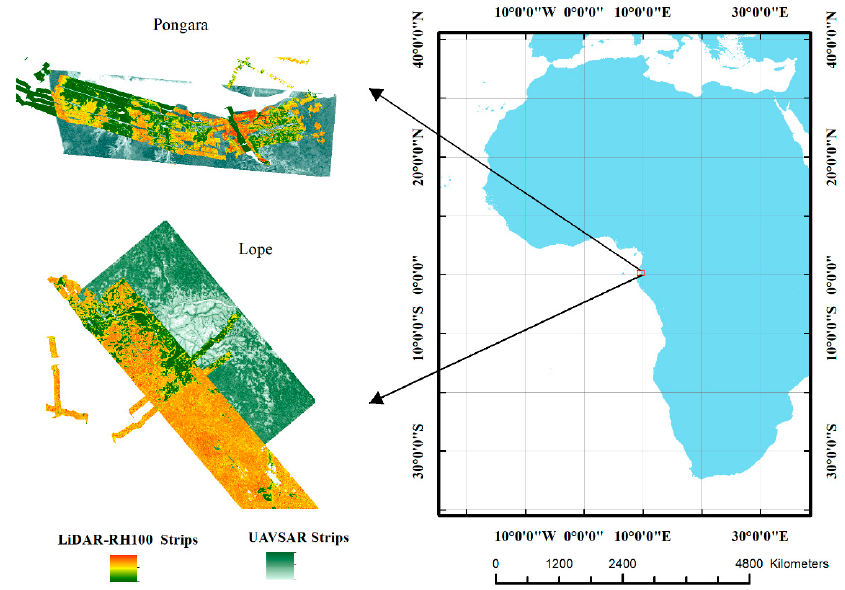
Figure 1. Location of the test area. Table 1. Forest conditions.